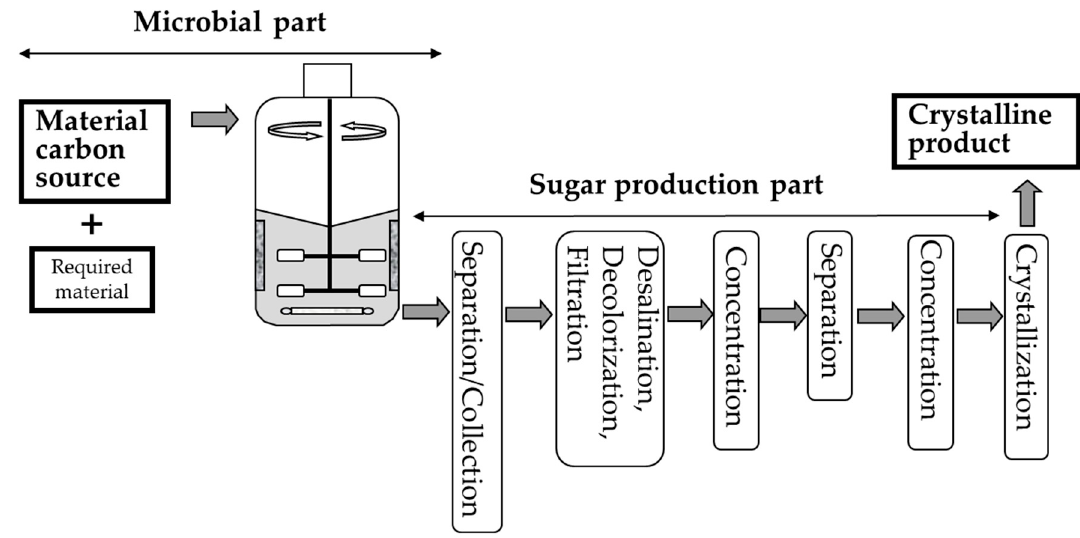
Figure 6. Schematic diagram of hexose production using fermentation.